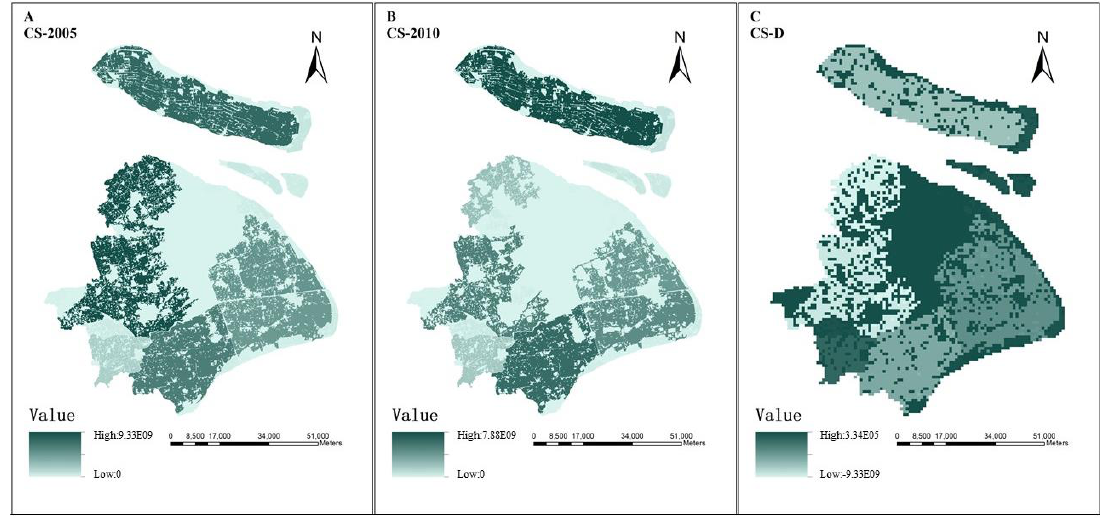
Figure 6. Spatial and temporal change of air purification service in Shanghai (sej/yr). ( A ) spatial distribution of AP in 2005; ( B ) spatial distribution of AP in 2010; ( C ) spatial change of AP.